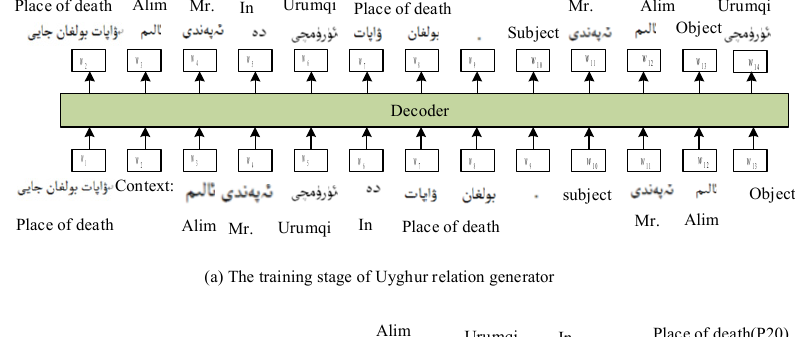
Table 1. Task examples of triplet extraction.